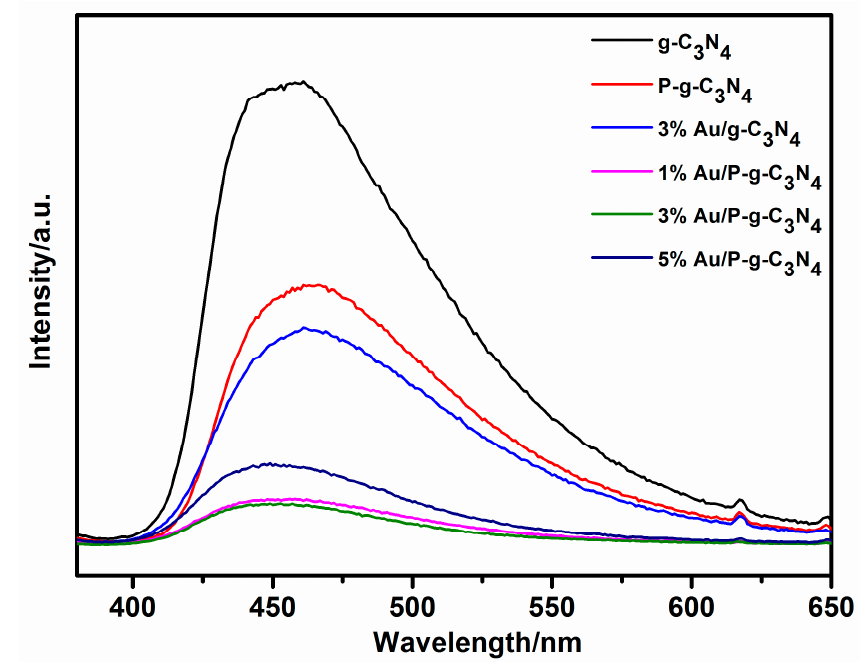
Figure 6. PL spectra of g-C 3 N 4 , P-g-C 3 N 4 , 3% Au / g-C 3 N 4 and di ff erent Au / P-g-C 3 N 4 composites.